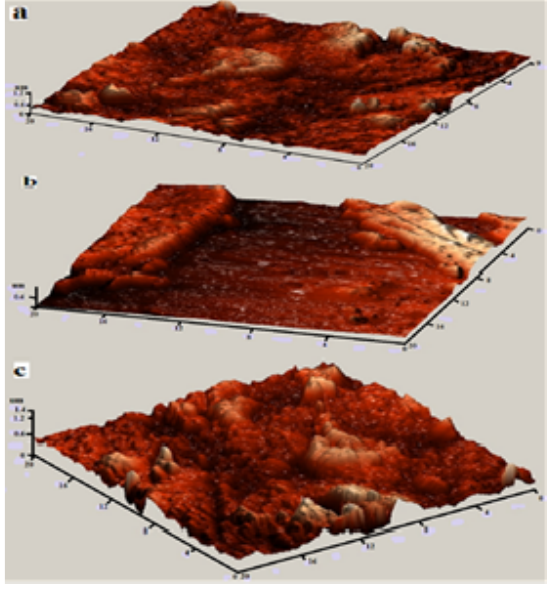
Fig 7. Atomic force micrographs of abraded AA3004 (image a) pre-treated AA3004 after corrosion (image b) and polyaniline-TiO nanocomposite coatings grown by an applied current density of 15 mAcm -2 after corrosion (image